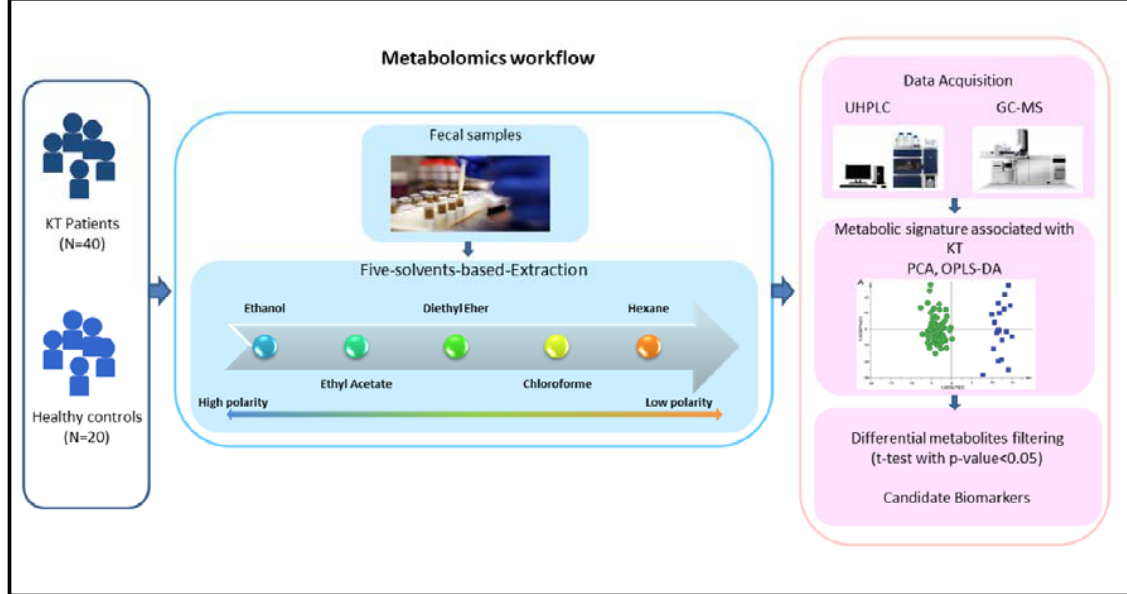
Figure 1. Workflow of UHPLC-GC/MS-based metabolomics for metabolomic profiling and data interpretation of fecal samples from stable kidney transplant patients.